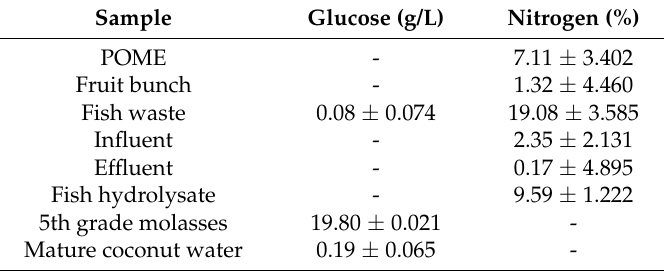
Table 1. Sugar and Nitrogen